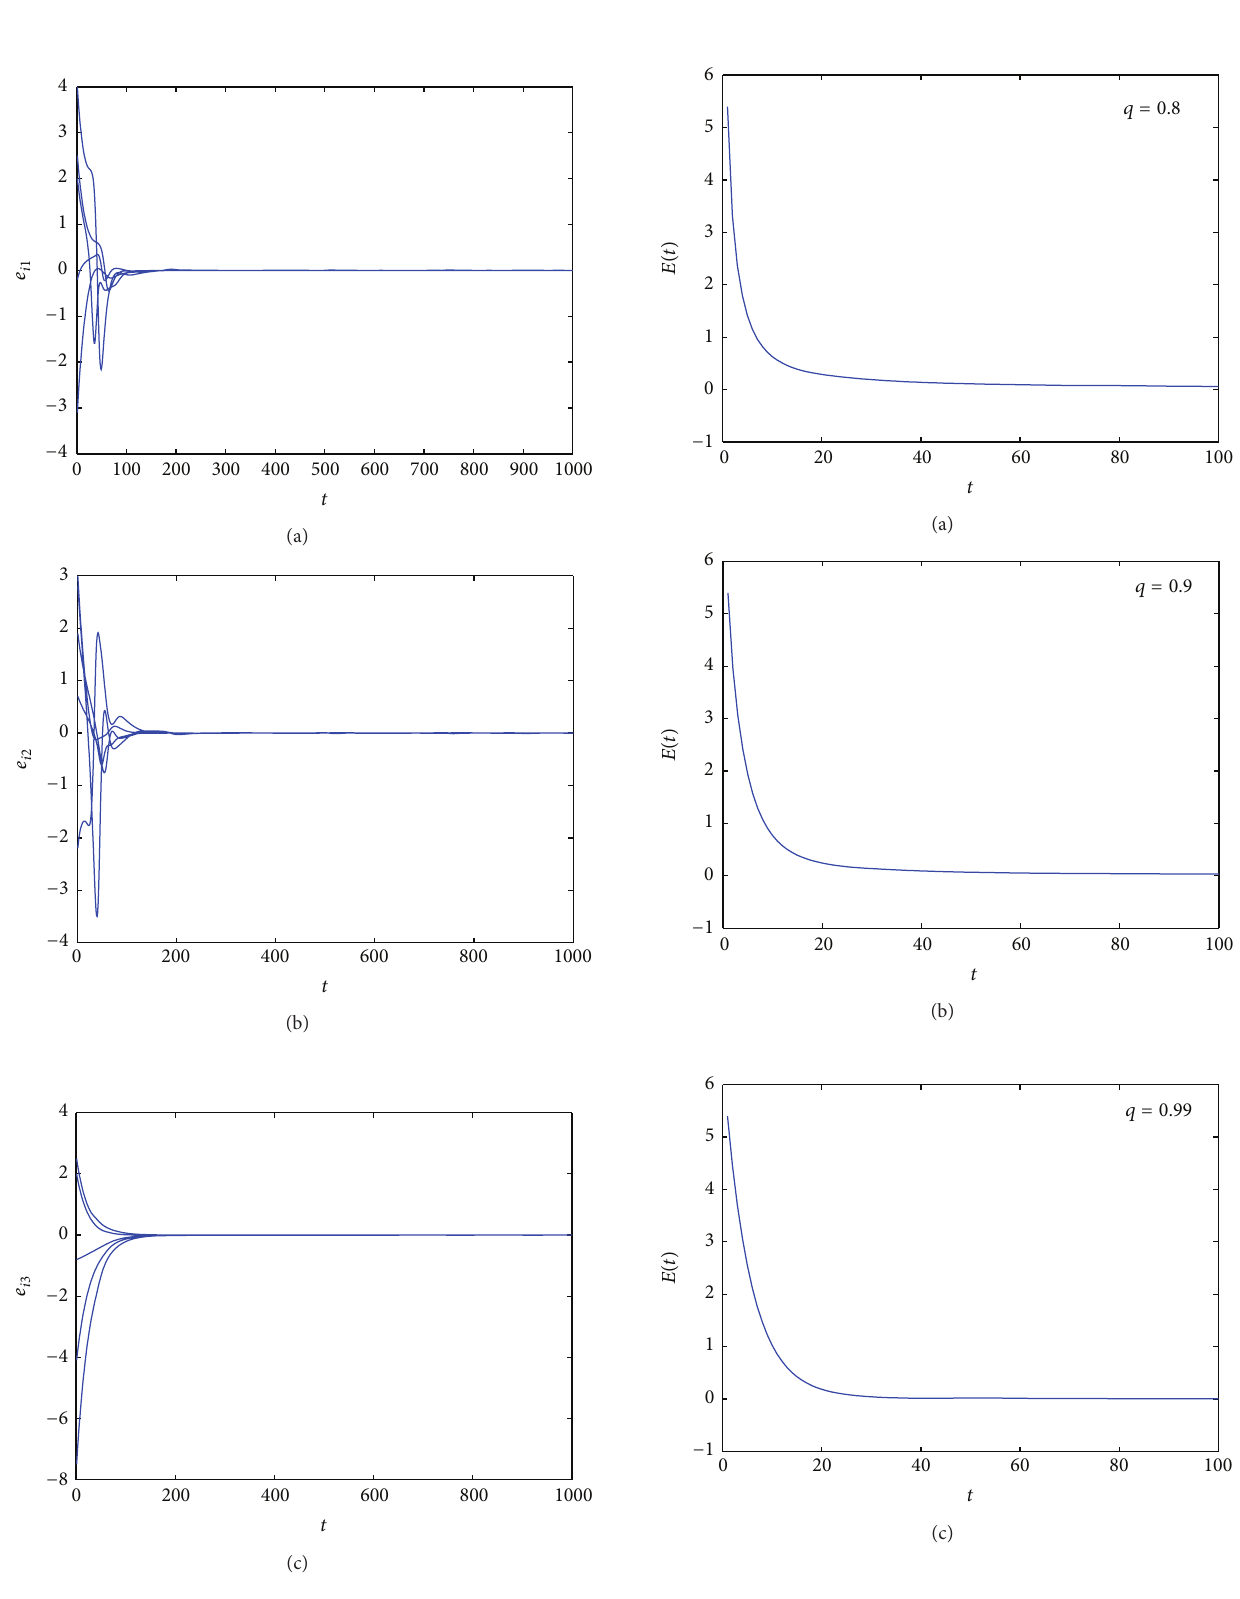
Figure 3: Time evolutions of MPOS synchronization error 𝑒 𝑖𝑛 with time.